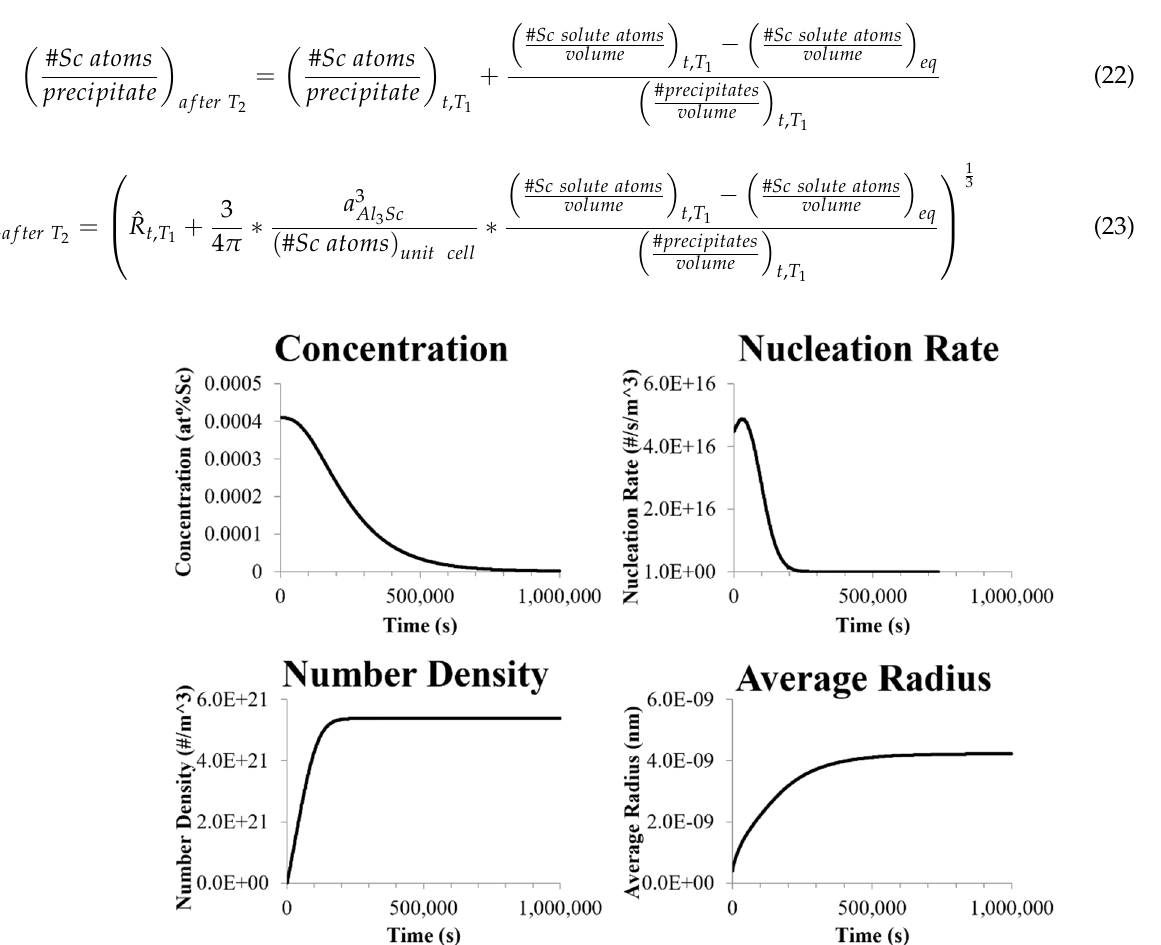
Figure 8. Simulated results for aging Al ‐ 0.04Sc at% for 1 × 10 6 s at 523 K (250 °C), similar to Figure 7. Note that nucleation effectively halts as Sc is depleted from the matrix.